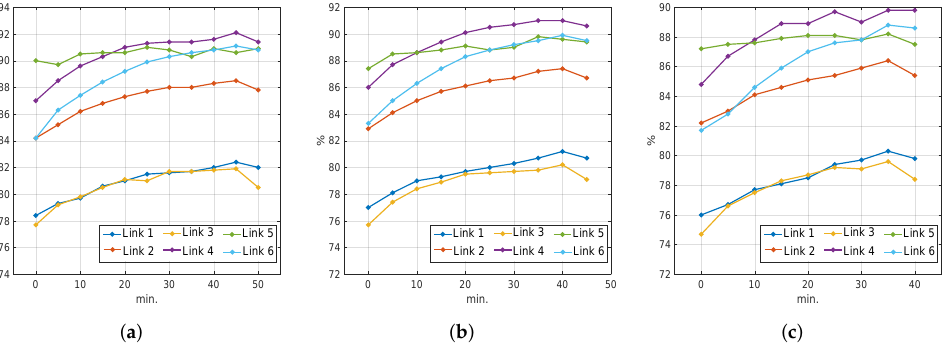
Figure 2. Evolution of the performance of predictors with t (cid:48) = 5min. ( a ) t (cid:48) = 10min. ATTs up to t − 50min. ( b ) and t (cid:48) = 15min. ATTs up to t − 45min. ( c ) depending on the input feature set. ATTs up to t −